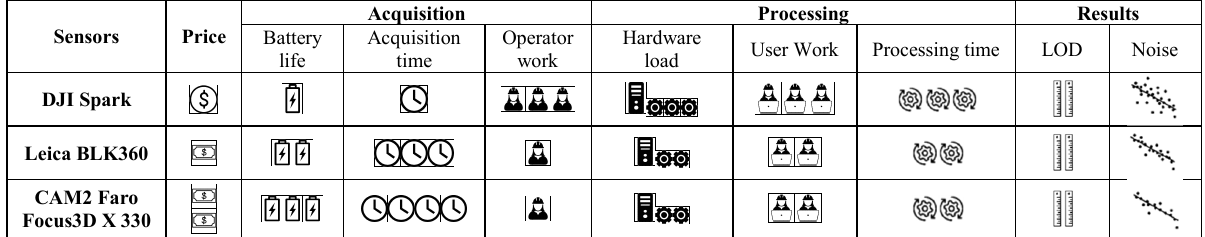
Table 11. Summarization of the characteristics of the employed sensors which influences the quality of the results, the user experience during the acquisition and the processing phases and the hardware